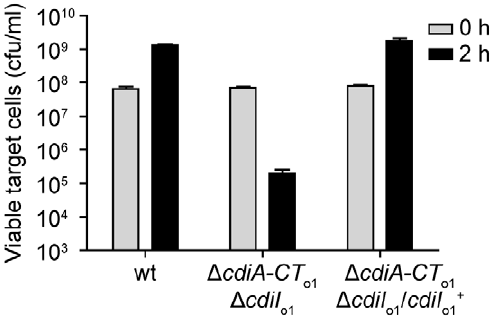
Figure 8. The EC93 orphan region produces functional CdiI o1 immunity protein. EC93 expressing chimeric CdiA EC93 -CT o1 EC93 was used as an inhibitor strain in growth competition experiments. Inhibitor cells were co-cultured with wild-type EC93, EC93 deleted for the orphan region ( D cdiA-CT o1EC93 D cdiI o1EC93 ), and EC93 D cdiA-CT o1EC93 D cdiI o1EC93 cells complemented with a plasmid-borne copy of cdiI o1EC93 ( cdiI o1 + ). Viable target cells were quantified by plating on selective media to determine the number of colony forming units (cfu) per milliliter.